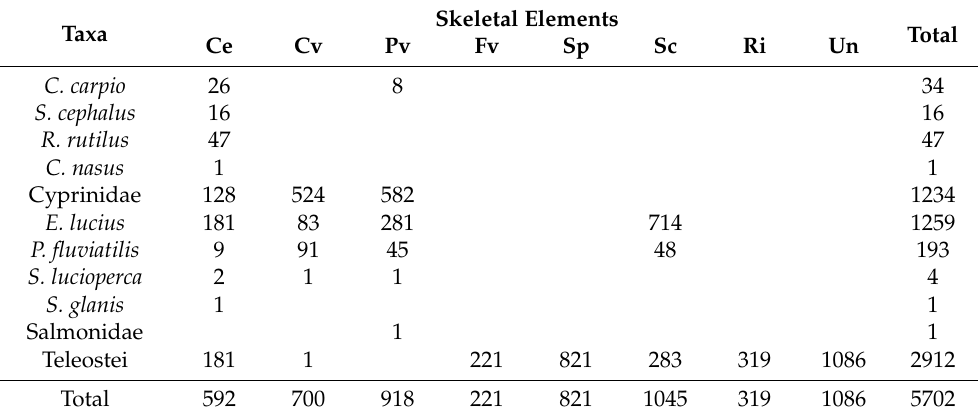
Table 4. Taxa, number and percentage of the anatomical element recovered in Borsodiv á nka during the 2020 campaign. Ce, cranial element; Cv, caudal vertebra; Pv, precaudal vertebra; Fv, fragment of vertebra; Sp, spine; Sc, scale; Ri, rib; Un, unidentified element. Taxa